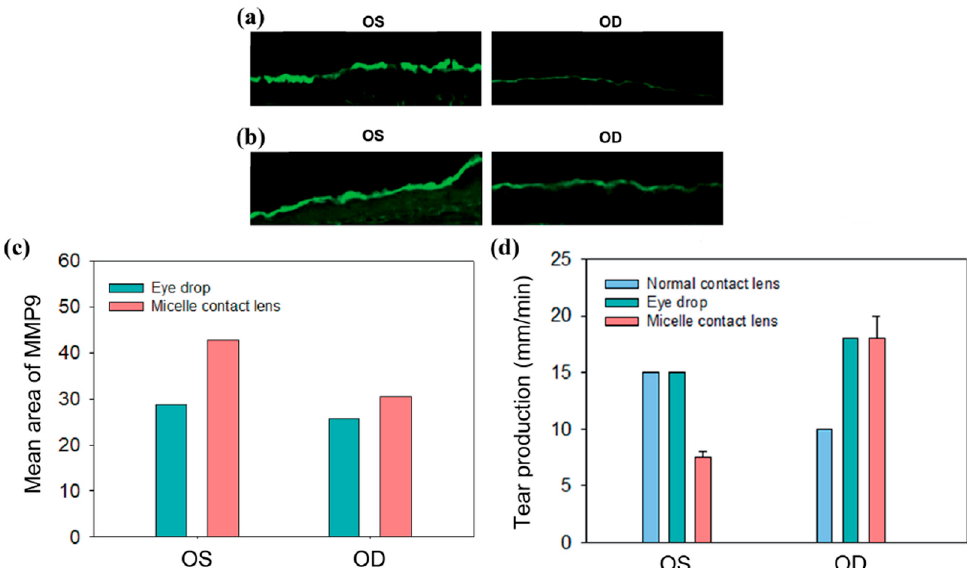
Figure 7. Analysis of corneal inflammation using the MMP9 DED marker (corneal immunofluorescein staining, green color) after ( a ) CsA eye drop application, and ( b ) CsA/C-HA micelle contact lens wear. ( c ) ROI values for MMP9. ( d ) Tear production by the contact lens-wearing (OD) and control (OS) eyes at day 7. Tear production was increased in the treated OD groups. Oculus dexter is abbreviated as OD, meaning right eye, and oculus sinister is abbreviated as OS, meaning left eye. Reprinted with permission from reference [103]. Copyright the Royal Society of